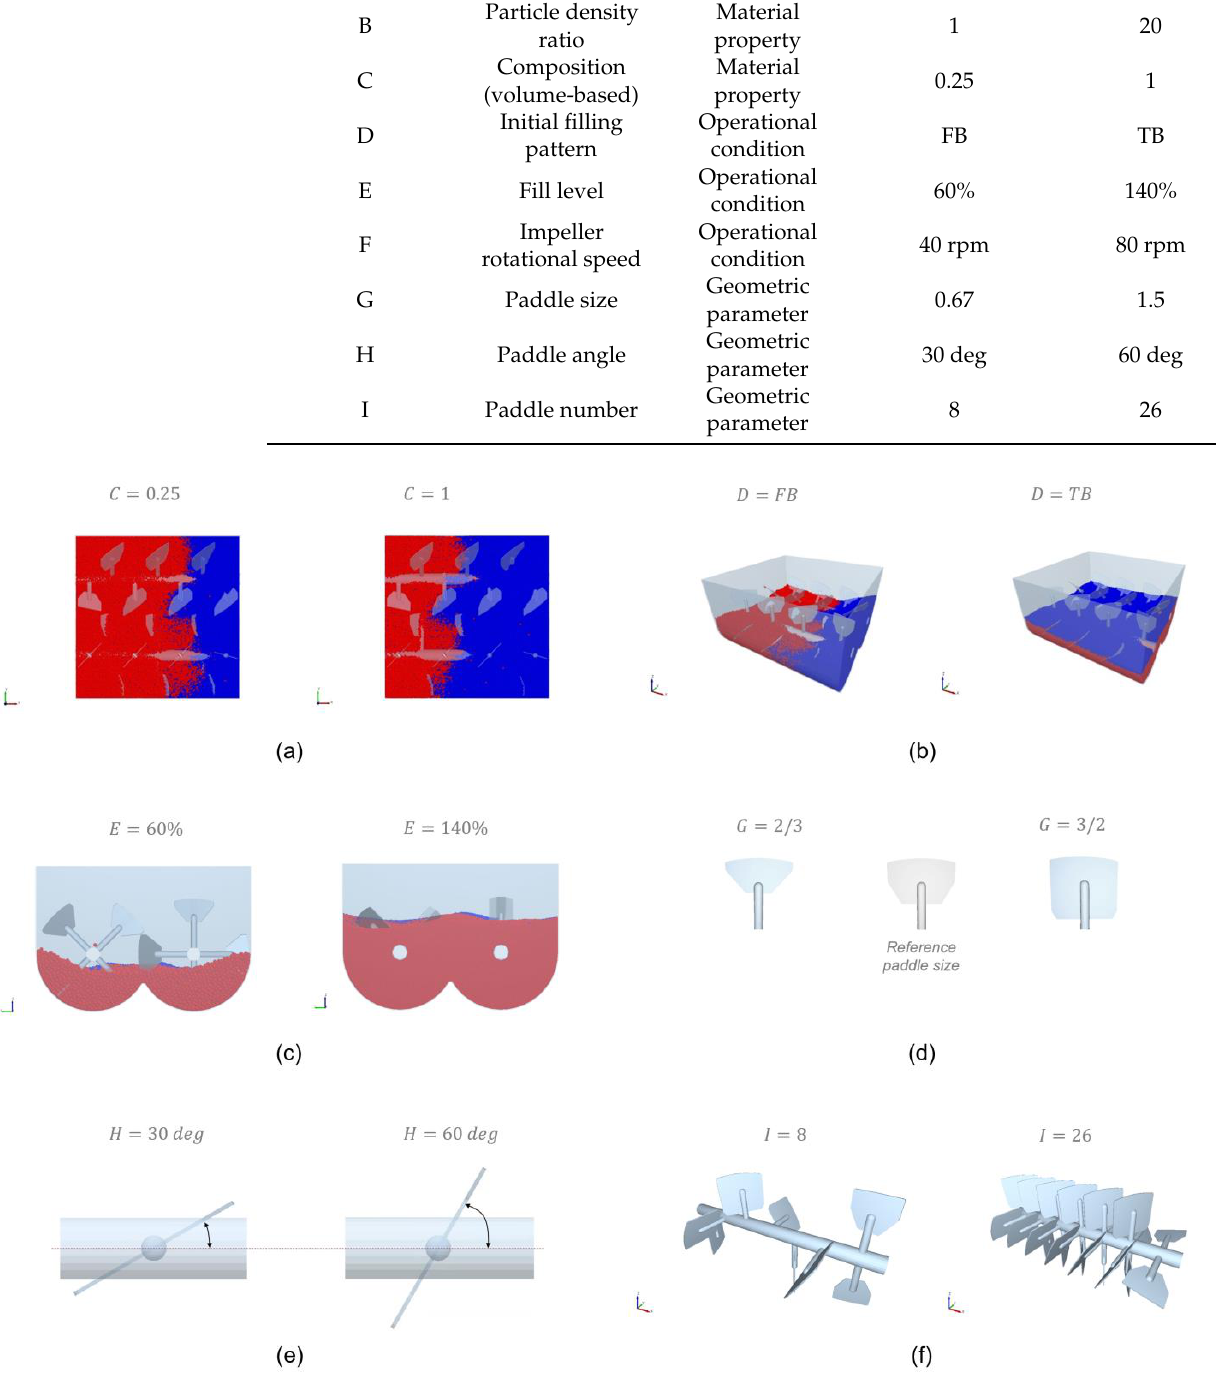
Figure 2. Illustrations of factor levels: ( a ) composition, ( b ) initial filling pattern (FB = Front-Back, TB = Top-Bottom), ( c ) fill level, ( d ) paddle size, ( e ) paddle angle and ( f ) paddle number.